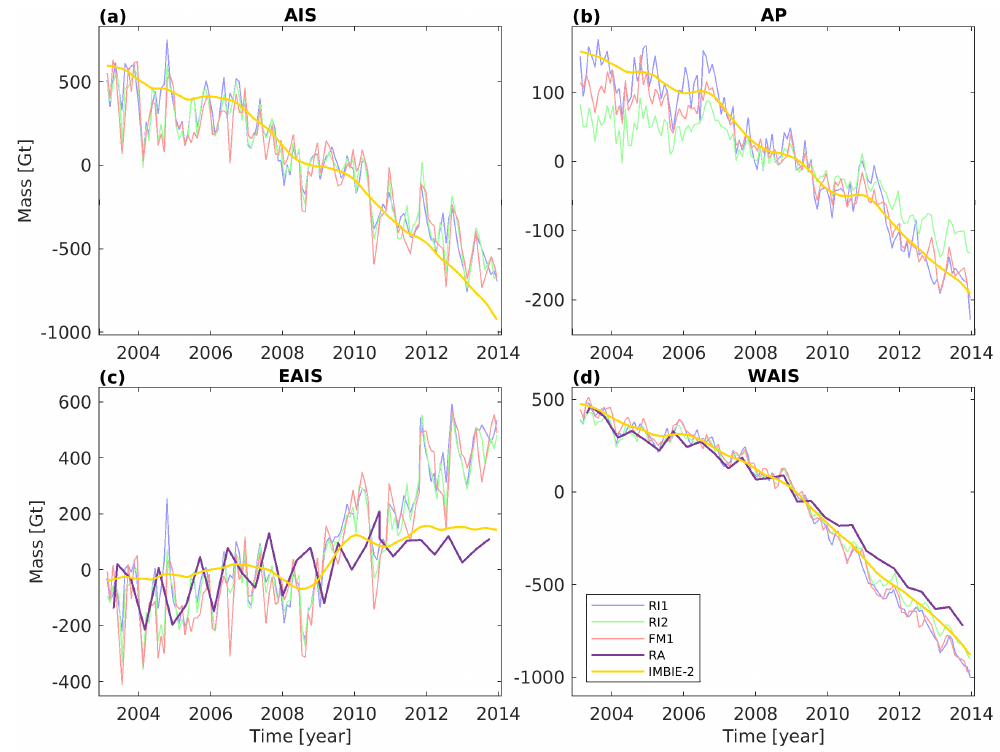
Figure 15. Comparison of GRACE-derived mass change time series for ( a ) the AIS, ( b ) the Antarctic Peninsula, ( c ) East Antarctica and ( d ) West Antarctica from three participants (faint colours) with a time series based on radar altimetry (RA) and a multi-sensor time series from IMBIE-2